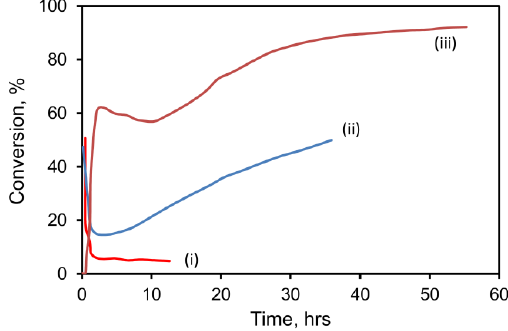
Figure 2. Conversion of 1% CO––air mixture over ( i ) pure mesoporous Au at 60 °C; ( ii ) mesoporous Au/Fe at 60 °C and ( iii ) mesoporous Au/Fe at 60 °C after 12 h of oxidation at 200 °C (space velocity at 60 °C was 18 L·g −1 ·h −1 for curves ( i ) and ( ii ), and 36 L·g −1 ·h −1 for curve ( iii )) (data courtesy of Project AuTEK, Mintek, South